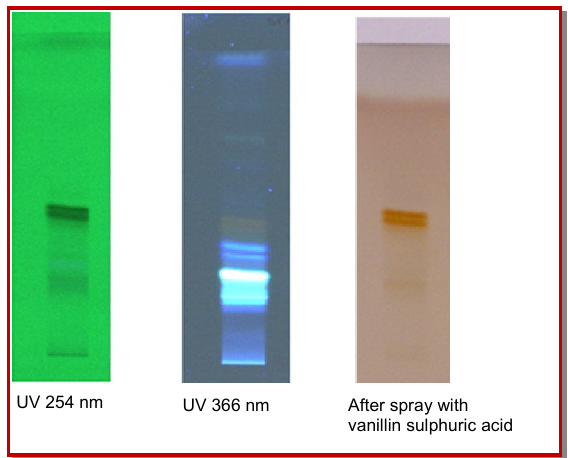
Figure 2: HPTLC profiling showing the presence of antimicro- bial compound at UV 254 and UV 366 after derivatization